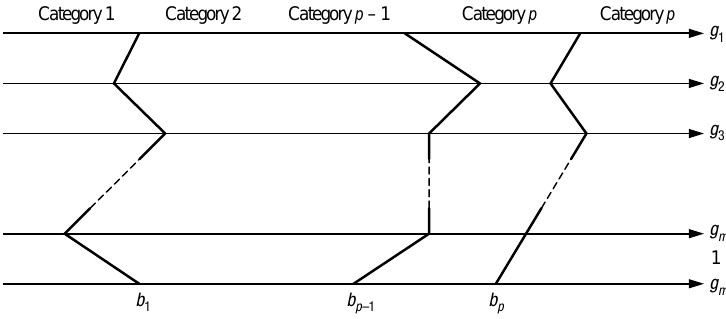
Fig. 4. Definition of categories using limit profiles (Mousseau and Slowinski